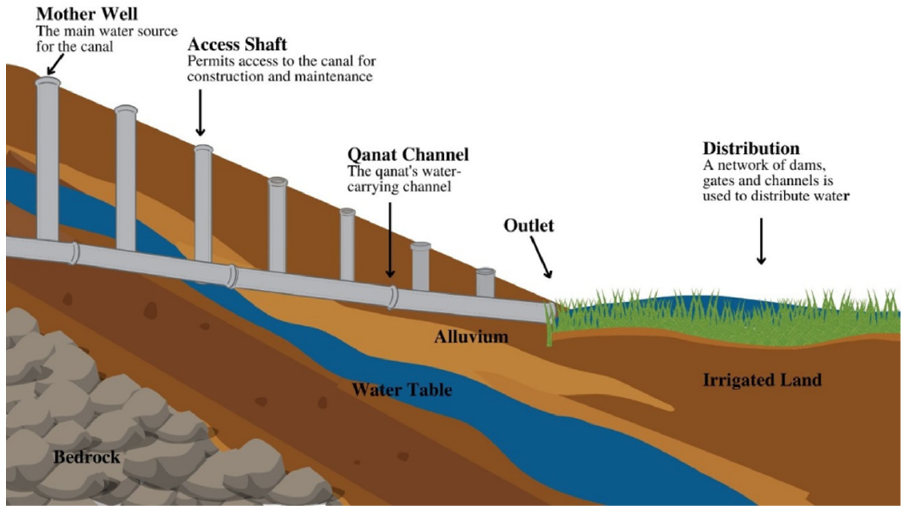
Figure 1. Design of a typical Qanat, the Persian underground irrigation canals.